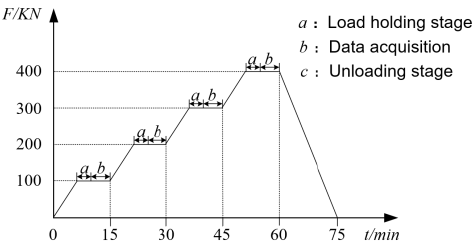
Figure 13. Loading details of static load test.